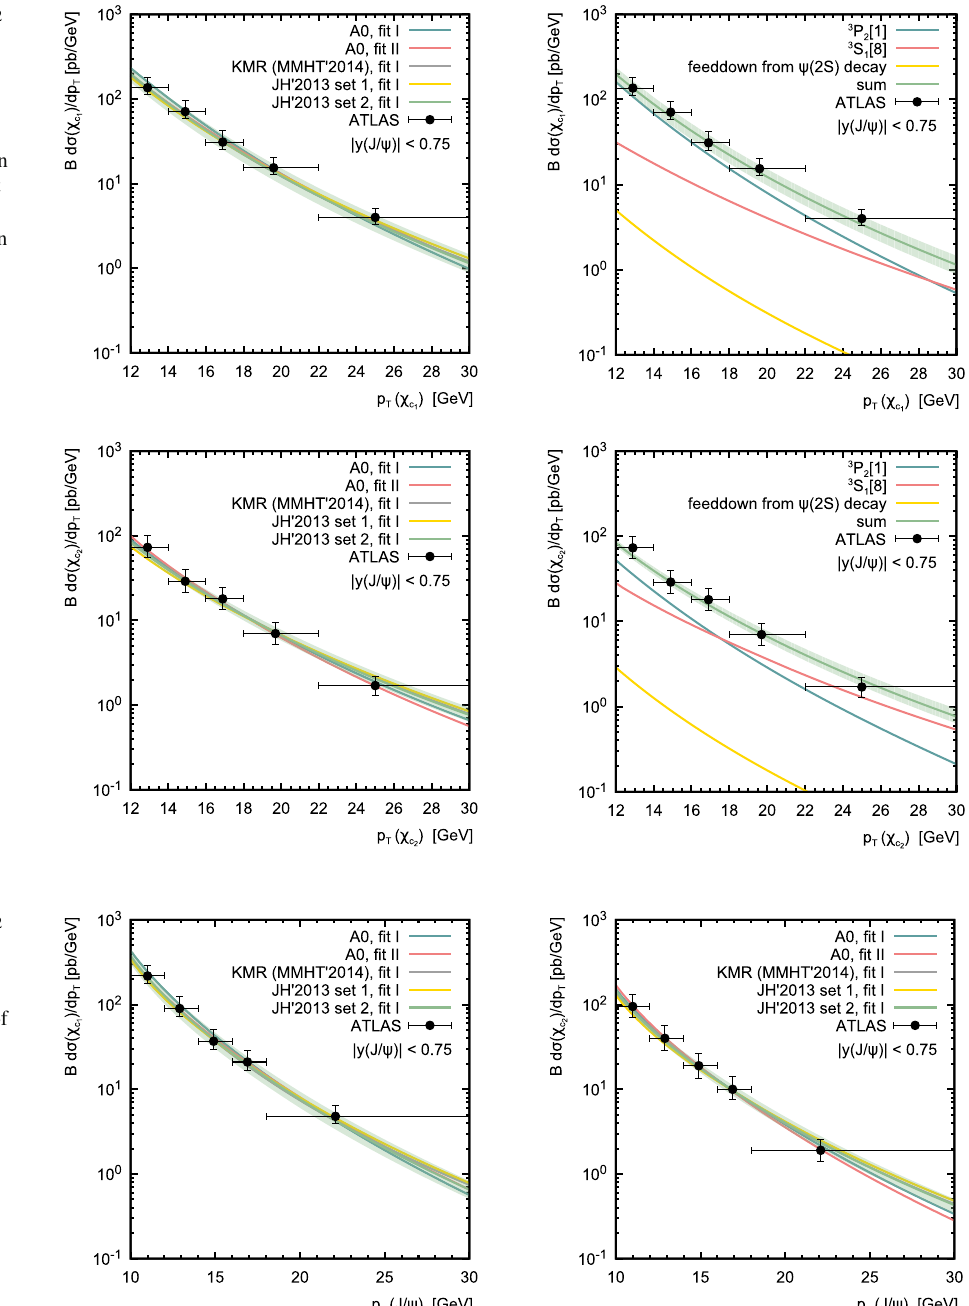
ties, the standard variations in the scale (by a factor of 2) were applied through replacing the JH’2013 set 2 gluon den- sity with JH’2013 set 2 + , or with JH’2013 set 2 − , respec- tively. This was done to preserve the intrinsic correspondence between the TMD set and scale used in the evolution equa- tion(see[43]formoreinformation).Wehaveachievedquitea nice agreement between our calculations and available LHC data. In particular, we obtained a simultaneous description of the transverse momentum distributions and the relative production rates σ(χ c 2 )/σ(χ c 1 ) . There are some deviations